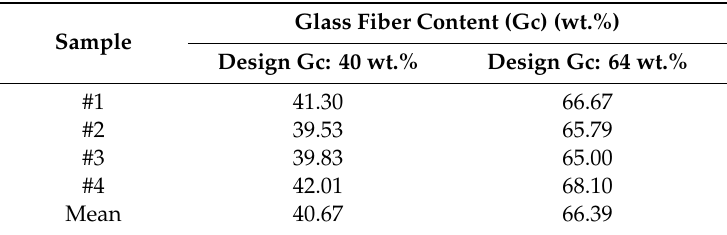
Table 5. Gc calculation result for specimens based on simple direct measurements.